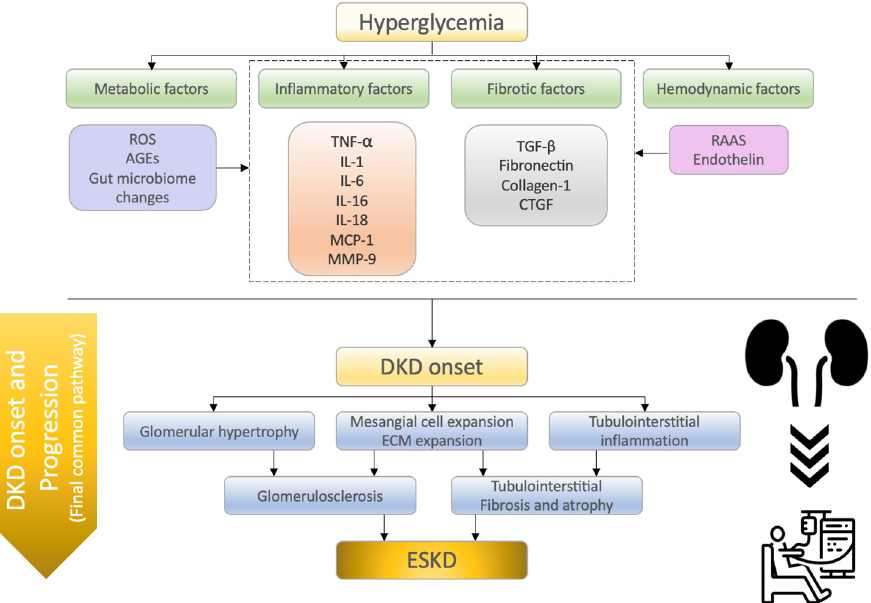
Figure 1. Summary of the molecular mechanisms of diabetic kidney disease (DKD) onset and progression. Several mechanisms contribute to the pathogenesis of DKD, including metabolic, inflammatory, fibrotic, and hemodynamic factors. These factors comprehensively induce albuminuria and reduce renal function. Finally, DKD patients develop ESKD through a final common pathway (glomerulosclerosis, tubulointerstitial fibrosis, and atrophy). ROS, reactive oxygen species; AGEs, advanced glycation end products; TNF- α , tumor necrosis factor- α ; IL-1, interleukin-1; IL-6, interleukin-6; IL-16, interleukin-16; IL-18, interleukin-18; MCP-1, monocyte chemoattractant protein-1; MMP-9, matrix metalloproteinase-9; TGF- β , transforming growth factor- β ; CTGF, connective tissue growth factor; RAAS, renin–angiotensin–aldosterone system; DKD, diabetic kidney disease; ESKD, end-stage kidney disease. Table 1. Summary of factors involved in the onset and progression of diabetic kidney disease (DKD).